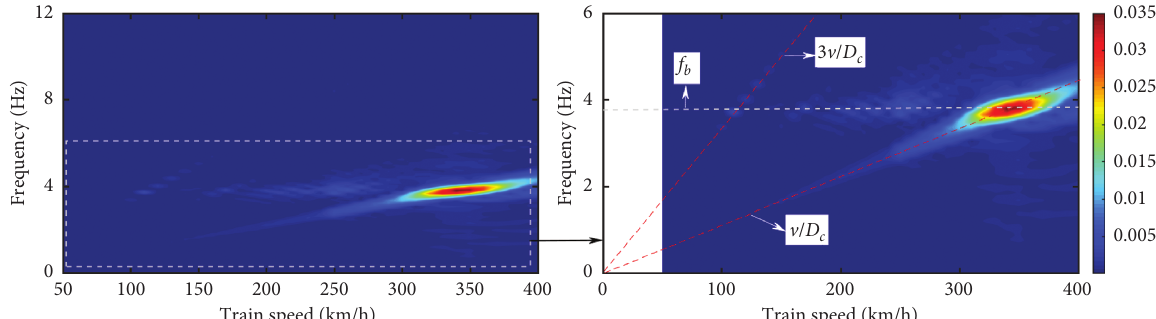
Figure 7: Bridge midpoint acceleration in the frequency-domain with various train speeds.